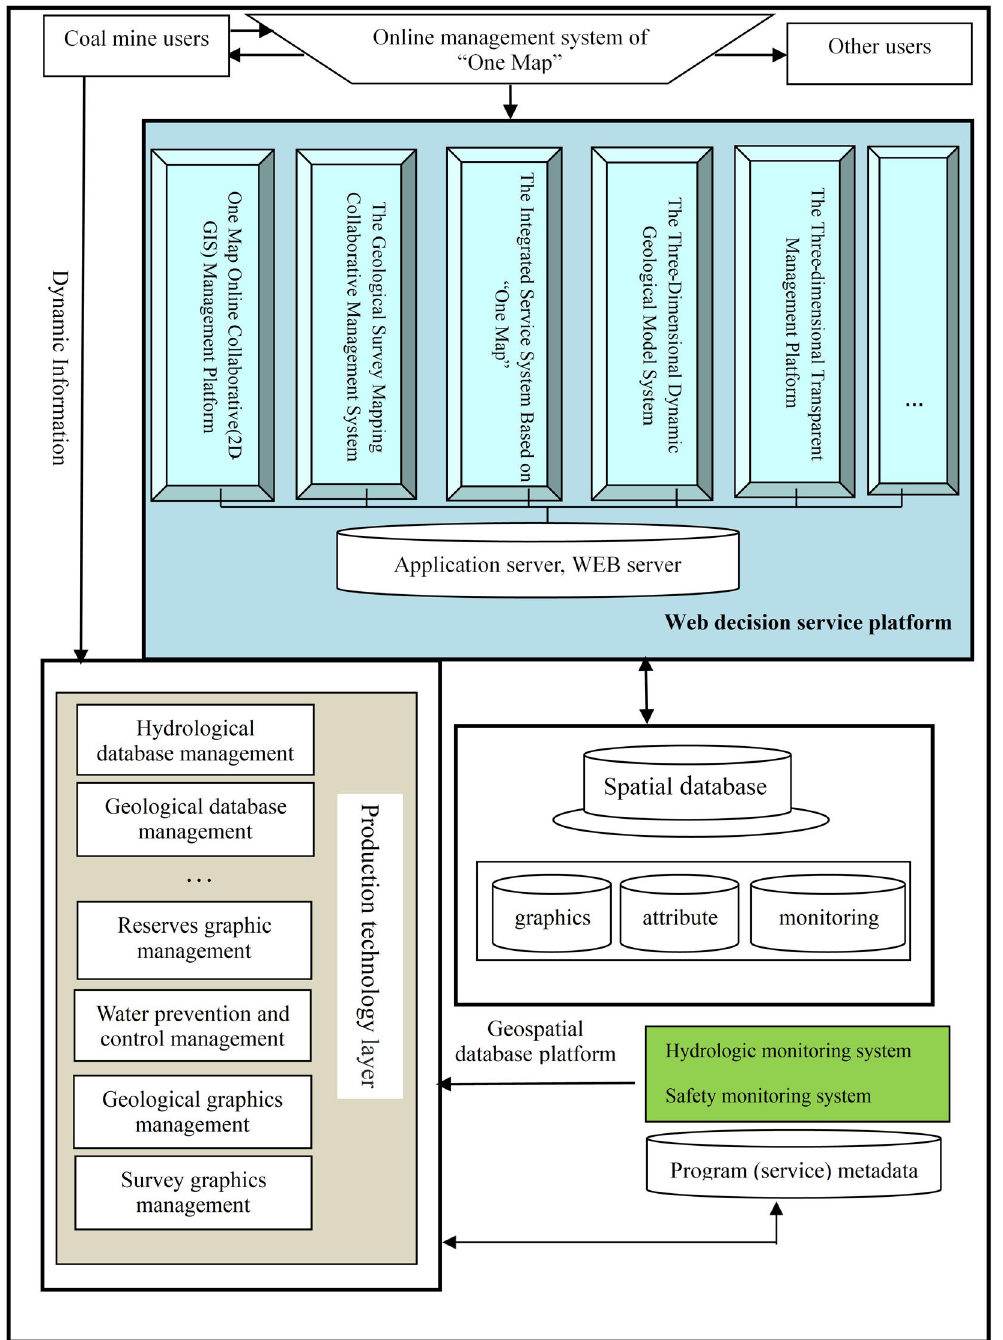
Fig. 1 Architecture of the geological and surveying spatial information management